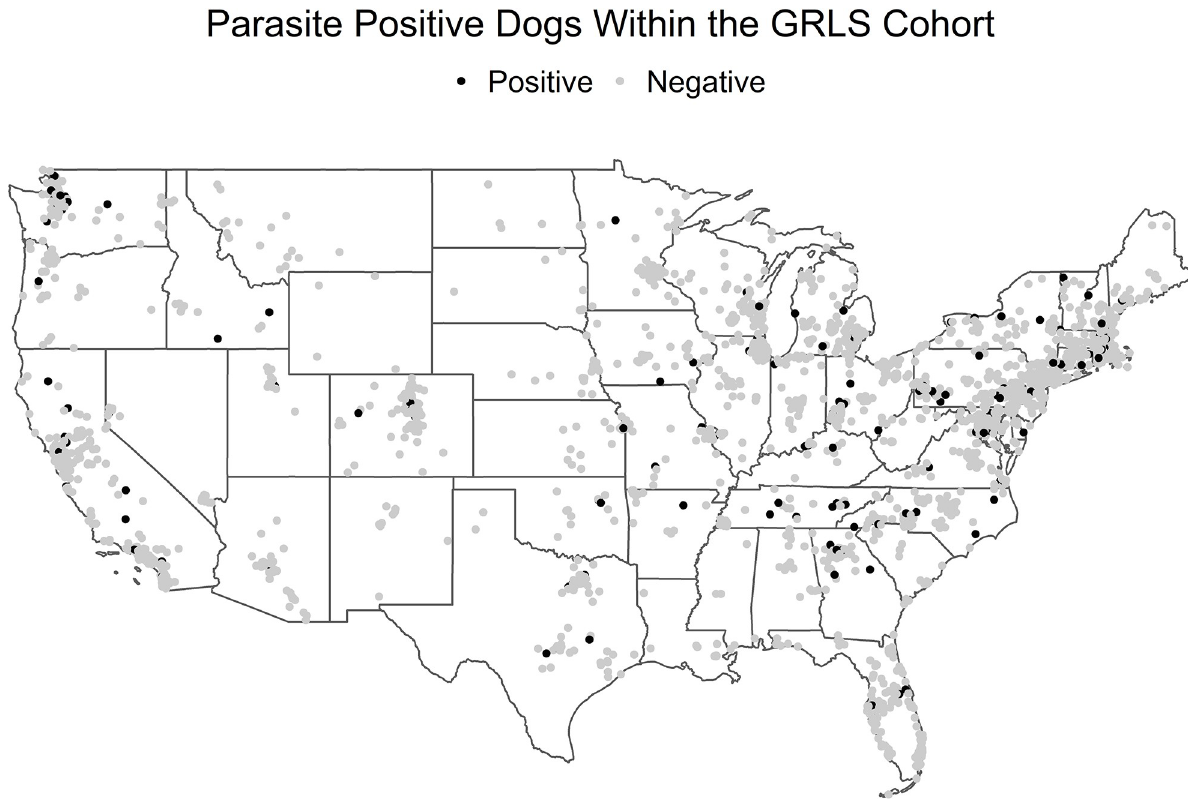
Fig 1. Geographic locations for parasite positive and negative dogs within GRLS cohort. Having a primary living location in the suburbs was associated with 0.57 decreased odds for being parasite positive (OR = 0.57, 95% CI = 0.42–0.77, P < 0.001) as compared to having the primary residence in a rural area according to the CBC model. The chemistry model showed a similar decreased odds for a dog being parasite positive when living in the suburbs (OR = 0.54, 95% CI = 0.40–0.73, P < 0.001).